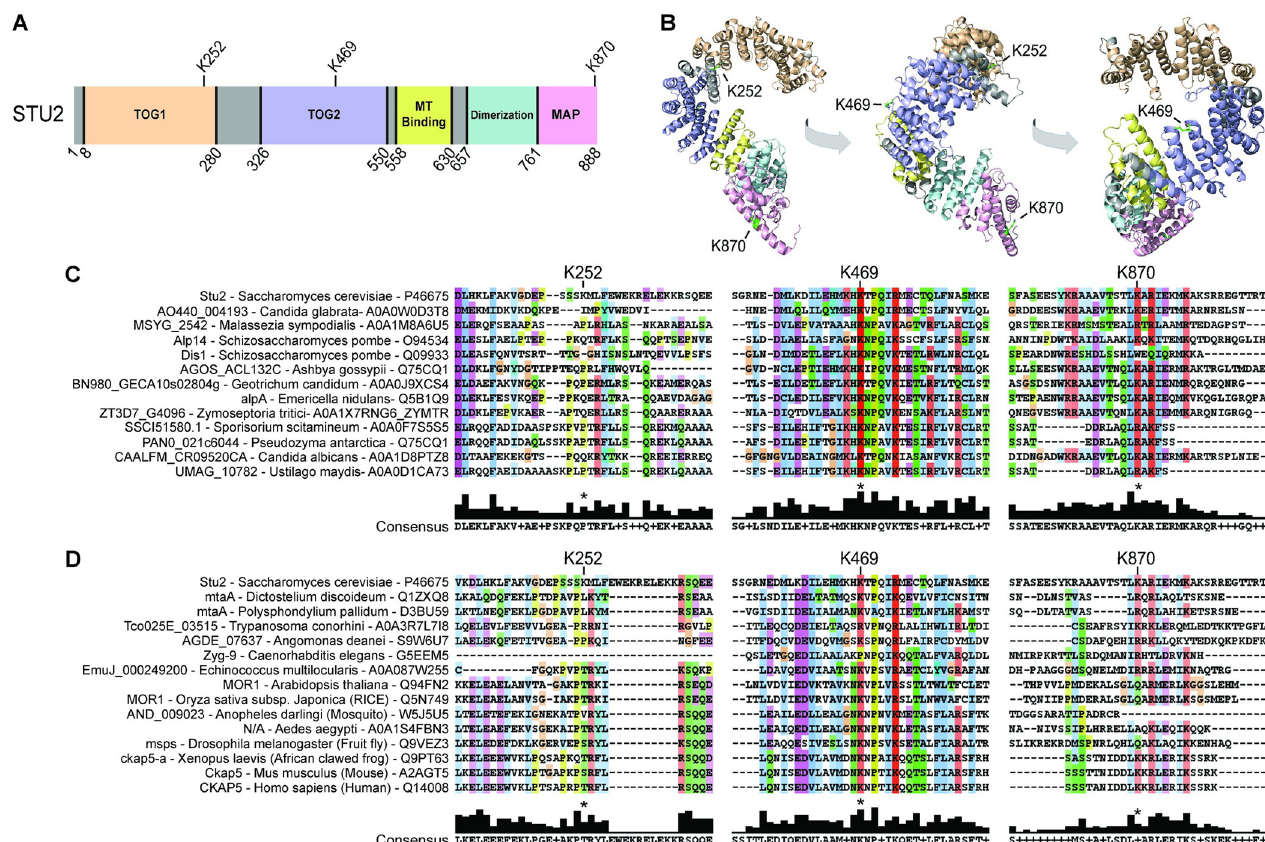
Fig 3. Stu2 lysines 469 and 870 are evolutionarily conserved. (A) The location of acetyl-lysines are indicated relative to distinct Stu2 domains and (B) are illustrated in a Stu2 structure predicted by I-TASSER. Clustal protein alignments are shown for members of the Stu2/XMAP215 family of microtubule polymerases for members across (C) fungi eukaryota and (D) eukaryota.